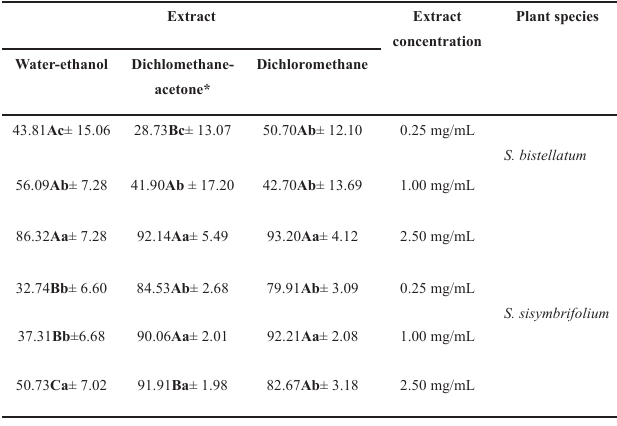
Table 2 . Mean repellency (%) of Solanum spp. extracts on C. brevis.